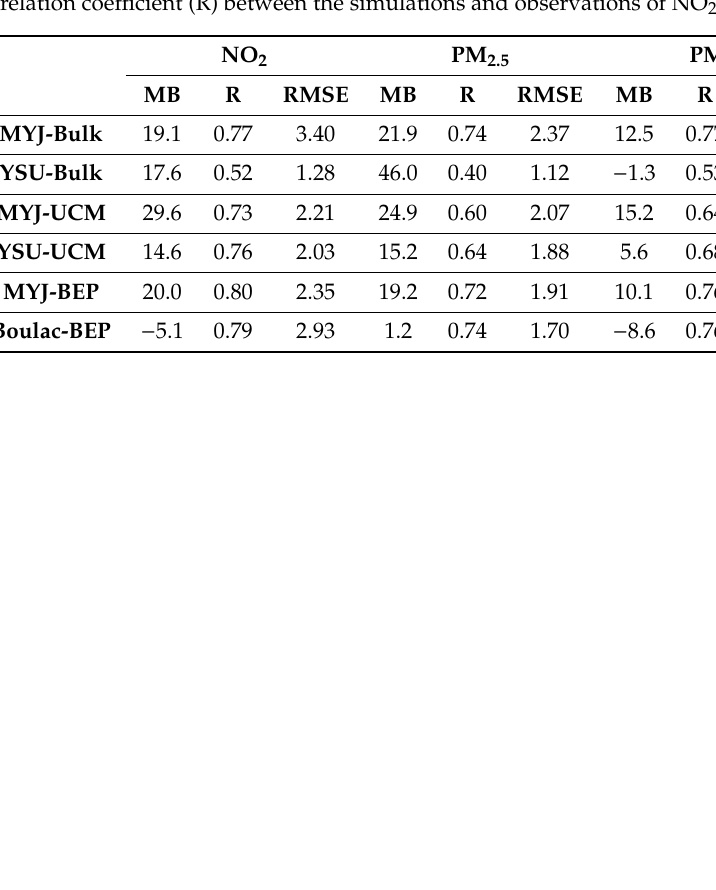
Table 4. Statistics of surface variables: mean bias (MB), root mean square error (RMSE), and mean linear correlation coe ffi cient (R) between the simulations and observations of NO 2 , PM 2.5 , PM 10